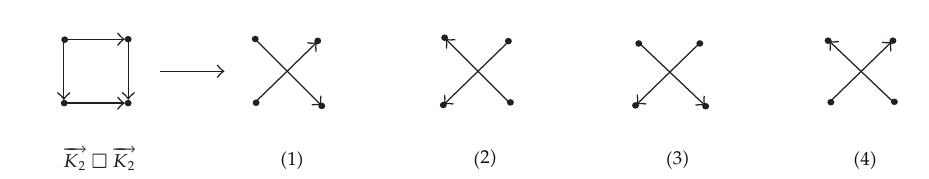
(cid:2)K × (cid:2)K 2 2